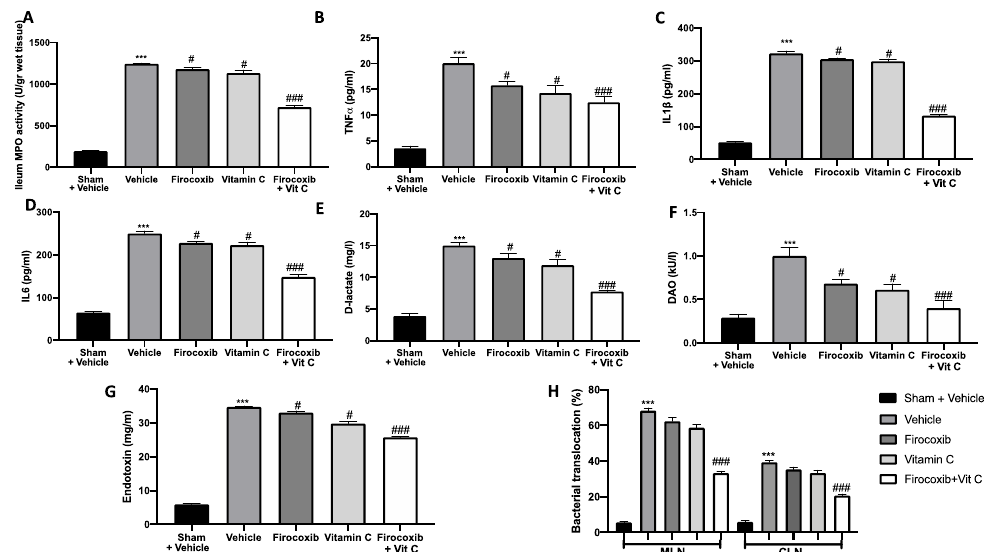
Figure 4. Effect of combined therapy of firocoxib and vitamin C on myeloperoxidase (MPO) activity, tumor necrosis factor alpha (TNF-α), interleukin (IL)-6, IL-1β, D-lactate, diamine oxidase (DAO), and endotoxin levels, and bacterial migration: ( A ) MPO activity, ( B ) serum TNF-α, ( C ) IL-1β, ( D ) IL-6, ( E ) D-lactate, ( F ) DAO, ( G ) endotoxin levels, and ( H ) bacterial translocation. n = 5 animals from each group for each analysis. A p -value of <0.05 was considered significant; # p < 0.05 vs. vehicle, *** p < 0.001 vs. sham + vehicle, and ### p < 0.001 vs. vehicle.